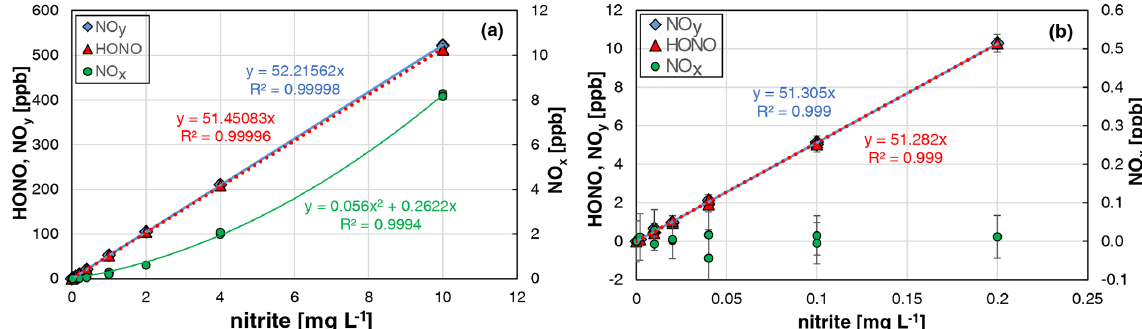
Figure 4. Nitrite concentration dependence of NO y , HONO, and NO x formation of the HONO source for two independent ex- periments. (a) All data including the data shown in Fig. 3; (b) same data for nitrite concentrations ≤ 0.2mgL − 1 ( T = 15.9 ◦ C, ∅ , dry = 2104cm 3 min − 1 , 20rpm, pH = 2.45 and 2.48). The error bars represent the 2 σ precision errors, which are smaller than the size of φ g the symbols in (a) .